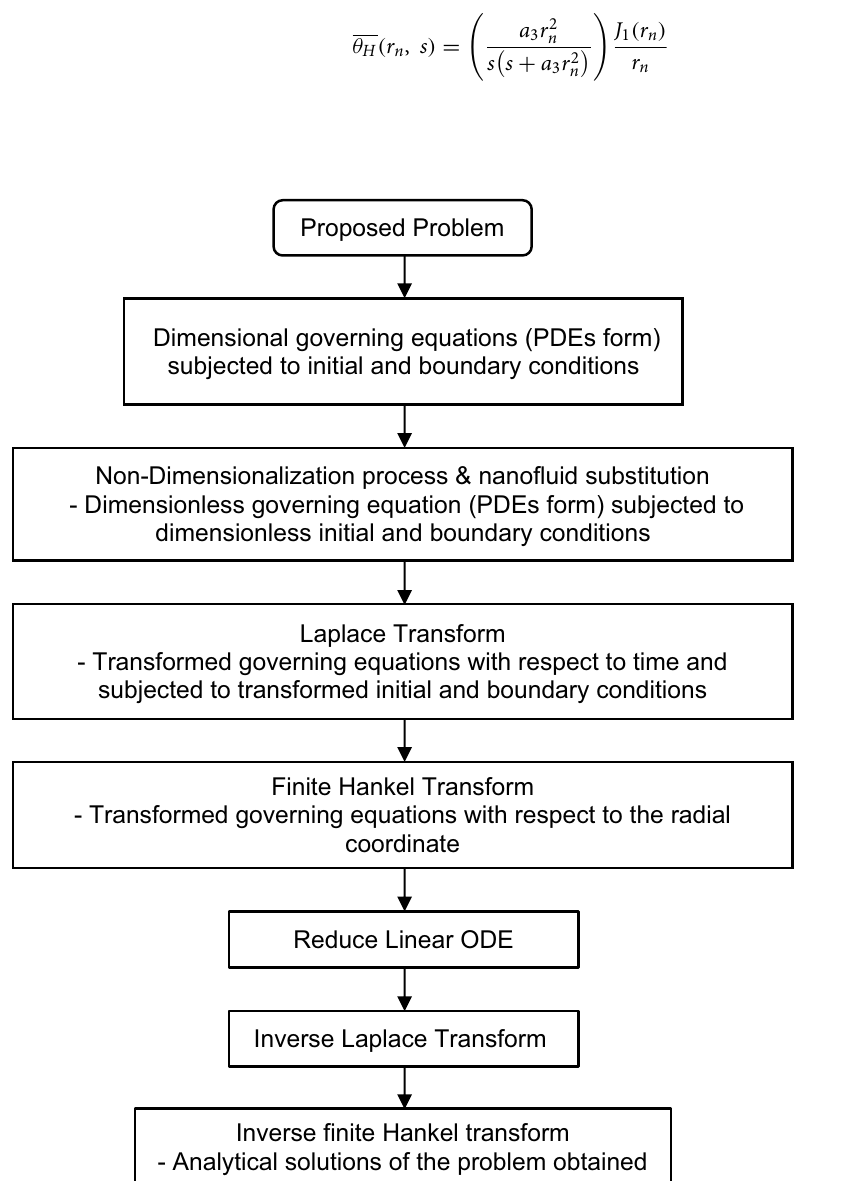
Figure 3. Methodology